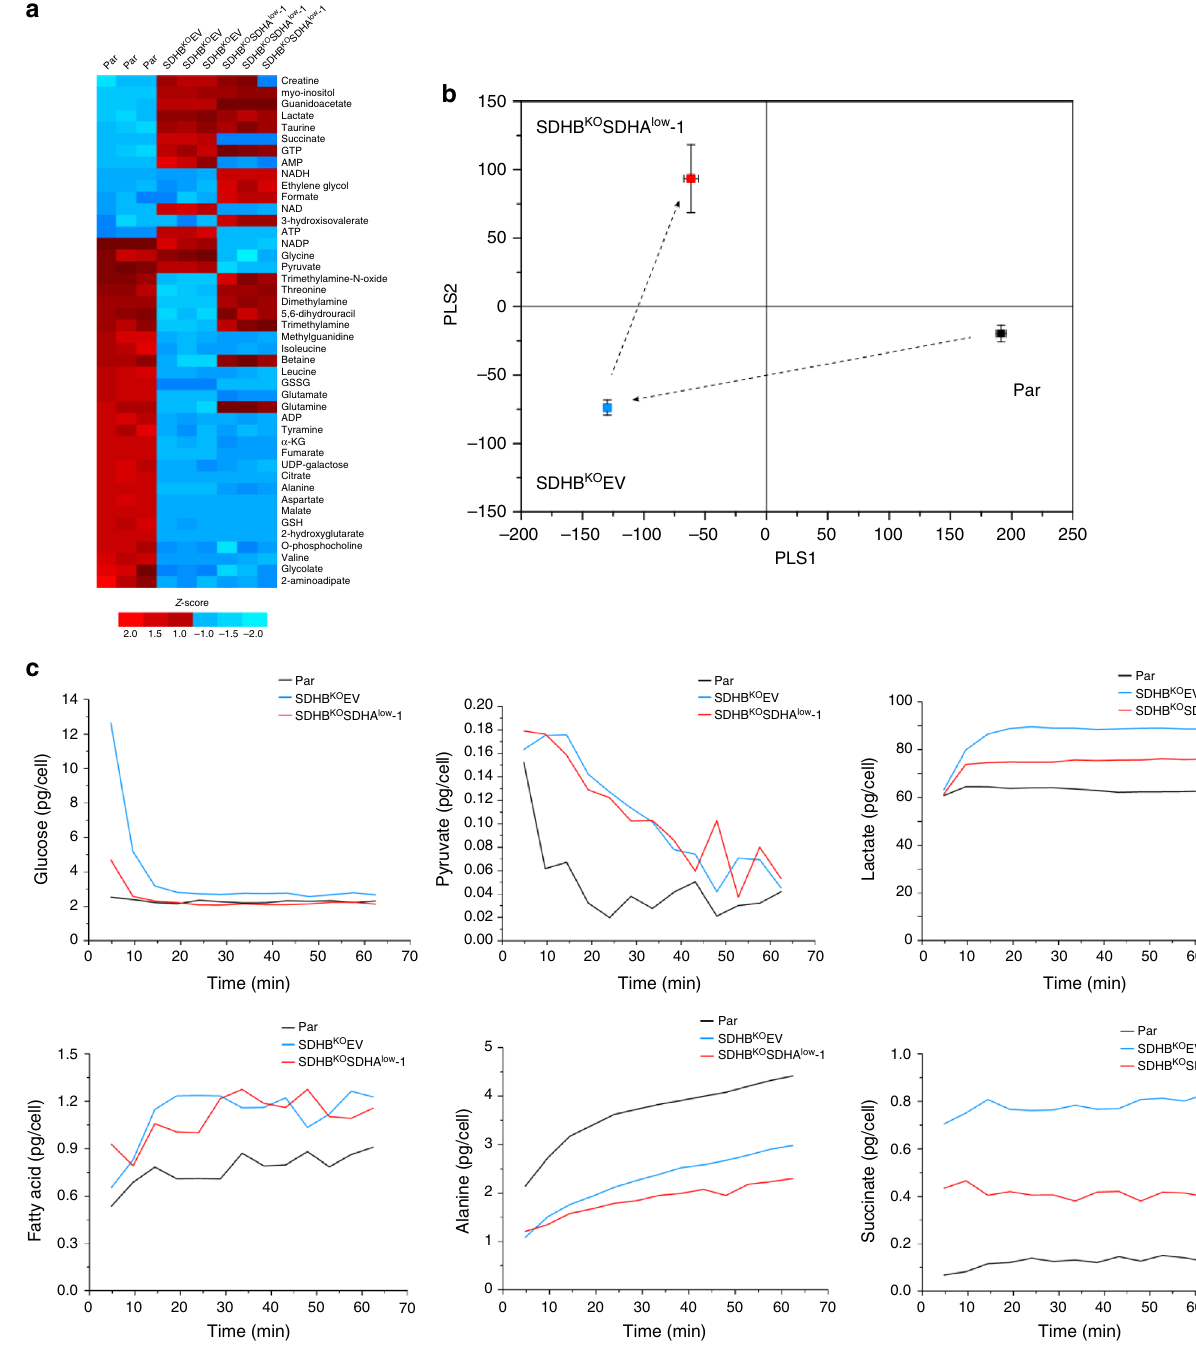
Fig. 6 CII low modulates metabolome of MDA231 sublines. a The heat map was constructed with the Z -score of peak intensities of each metabolite identi fi ed by both 1D NMR and LC-MS/MS from parental, SDHB KO EV, and SDHB KO SDHA low cells. The Z -score was obtained by dividing the difference between actual peak intensities and mean value by the standard deviation. b Score plot from partial least squares discriminant analysis (PLS-DA) on MDA231 sublines with the entire 1D NMR spectral data. PLS1 axis accounts for the major metabolic discrimination (63.5%), and the PLS2 16.8%. The symbols represent the mean score values from the multivariate analysis and the whiskers represent one standard deviation. Transitions are shown by arrows. c Real-time fl ux comparison in live parental, SDHB KO EV, and SDHB KO SDHA low cells. Time-dependent metabolic changes were obtained using 2D in-cell NMR metabolomics approach. The absolute quanti fi cation is based on the level of 13 C carbon on a particular atom of metabolites detectable by NMR and was performed as described previously 39 . Although it is not possible to differentiate pre-existing natural abundance metabolites with those derived from 13 C-glucose with real-time NMR, the natural abundance of 13 C is 1% and pre-existing metabolites should not make signi fi cant contributions to the quantitation. Fatty acid represents the aggregate level of the 13 C-labeled CH 2 peak from free fatty acids at 1.36 and 32.0 ppm on the HSQC spectrum. Parental, black; SDHB KO EV, blue; SDHB KO SDHA low ,